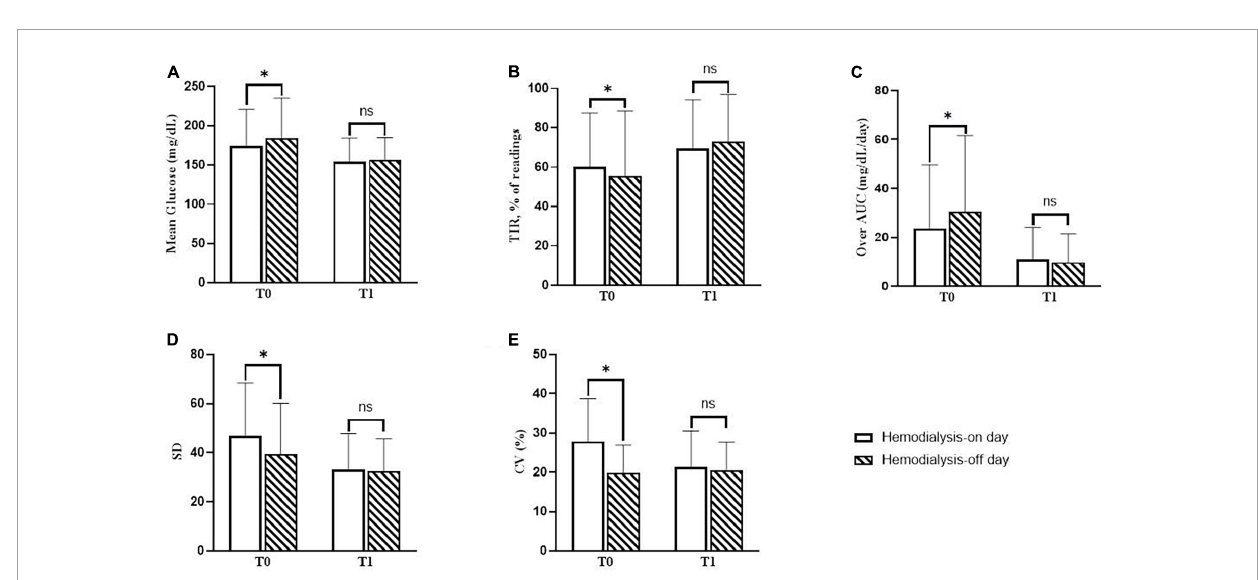
FIGURE3 Changes in continuous glucose monitoring (CGM) metrics on days with or without hemodialysis sessions. (A) The difference in mean glucose levels between the hemodialysis-on and hemodialysis-off days during baseline (T0) and follow-up (T1). (B) The difference in mean percentage of readings within time in range (TIR) between the hemodialysis-on and hemodialysis-off days during T0 and T1. (C) The difference in over-area under the curve (AUC) between the hemodialysis-on and hemodialysis-off days during T0 and T1. (D) The difference in standard deviation (SD) between the hemodialysis-on and hemodialysis-off days during T0 and T1. (E) The difference in percentage the coefficient of variation (%CV) between the hemodialysis-on and hemodialysis-off days during T0 and T1. P -values were calculated using the paired t -test or the Wilcoxon signed-rank test. ∗ P < 0.05 was considered statistically